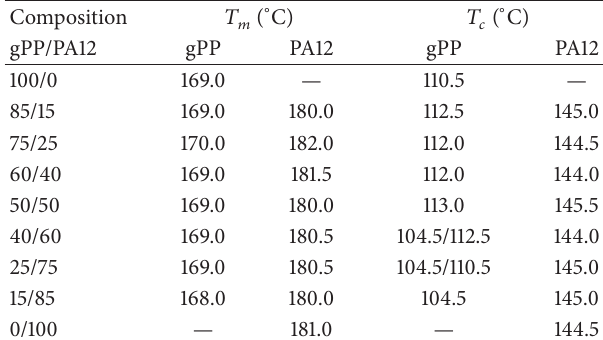
Table 1: Glass transition temperatures of the gPP/PA12 blends. The average standard deviation is 1 ∘ C.